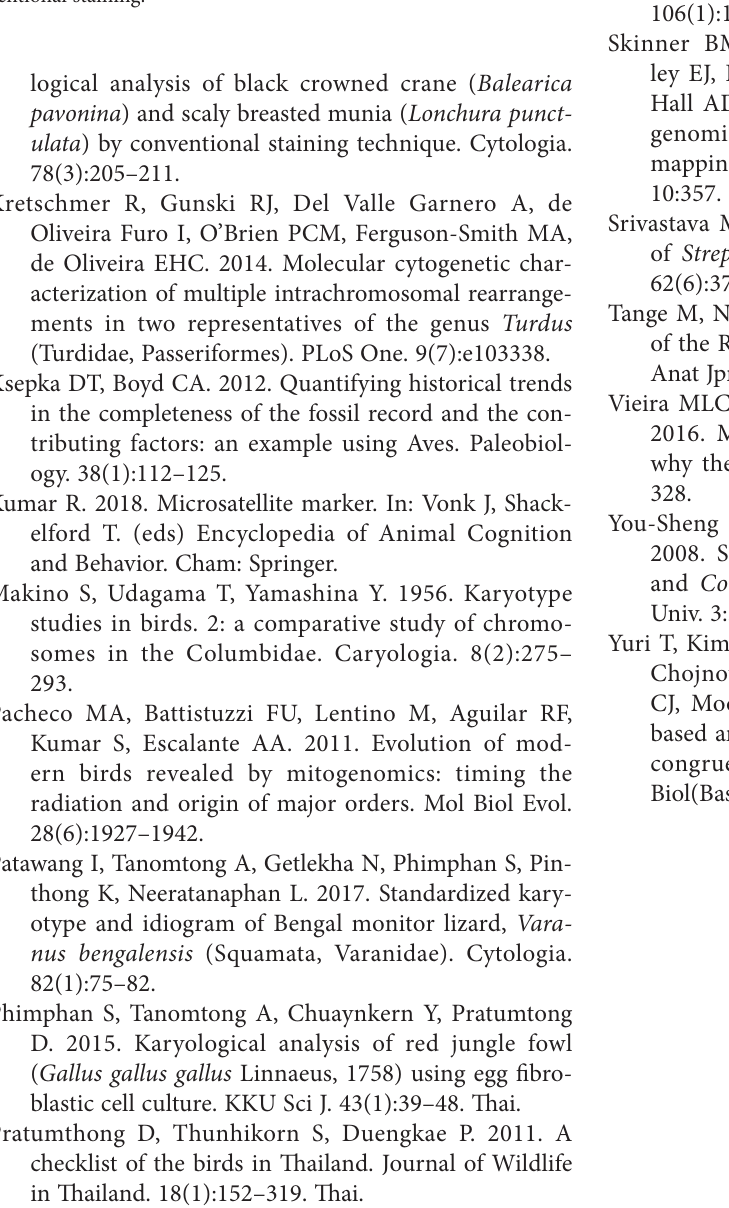
Figure 5. Standardized macro-chromosomal idiogram of Tachybap- tus ruficollis , 2 n =60 (a) and Spilopelia chinensis , 2 n =70 (b) by con- ventional